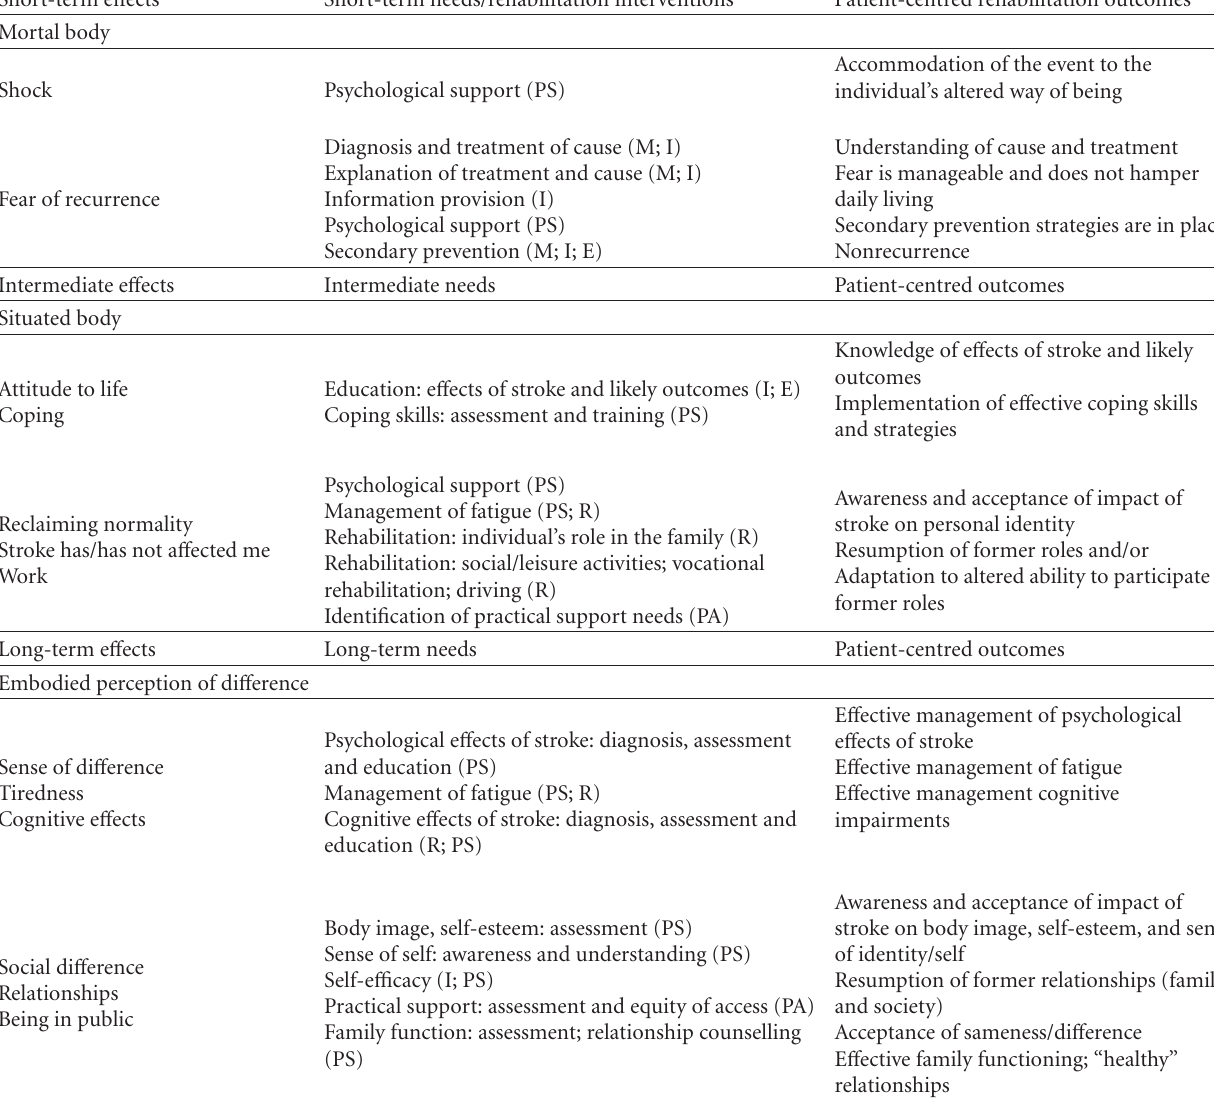
The table is divided into three sections: mortal body, situated body, and embodied perception of di ff erence, which reflect the subthemes from the qualitative interviews. These sections are mapped to short-, medium-, and long-term e ff ects of stroke. This temporal perspective reflects the ways in which the experience of stroke and associated needs and outcomes change over time. The table comprises three columns, that is, e ff ects of stroke, patient-centred needs/rehabilitation interventions, and patient-centred rehabilitation